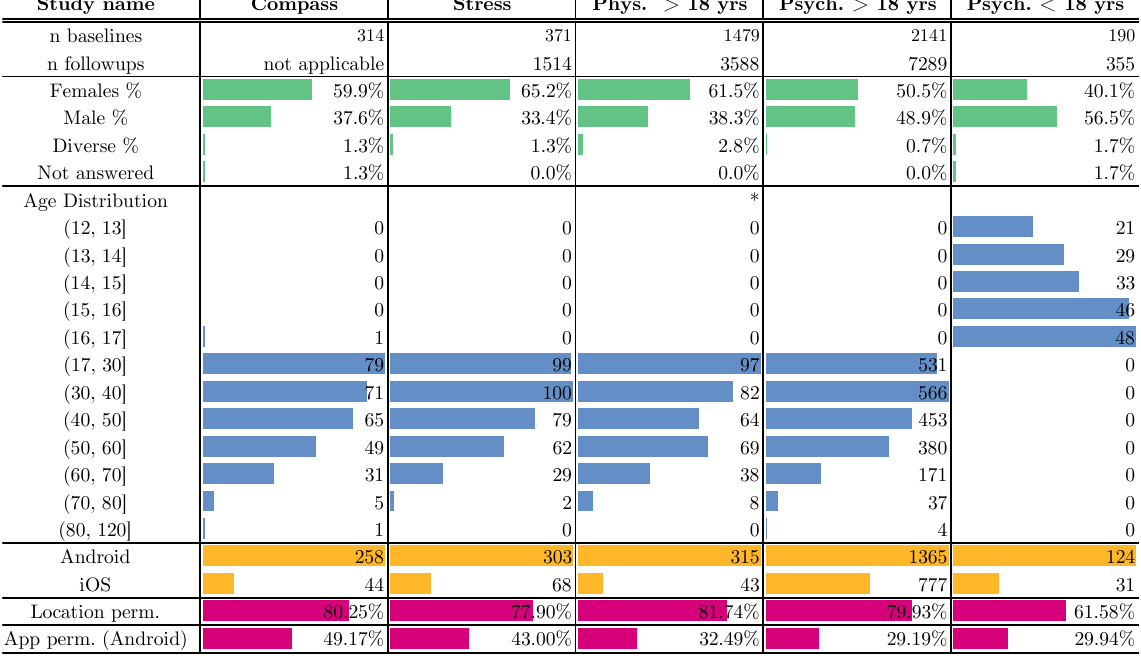
Figure 9. Fact sheet for the five studies. A total of 17,241 questionnaires were completed by 11 May 2021. Note that demographic information was not available for the Adult Physical Health Questionnaire (Study “Phys. > 18 yrs”) until